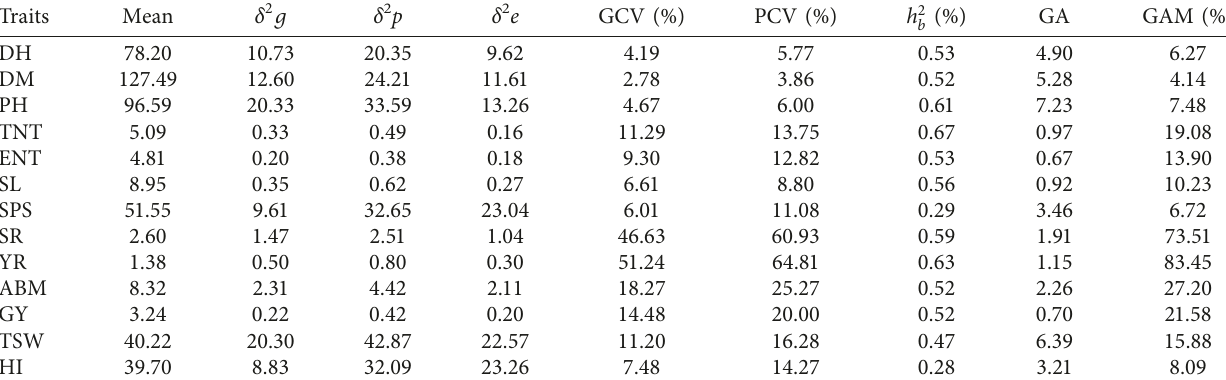
Table 11: Estimates of variance components at Kechi experimental